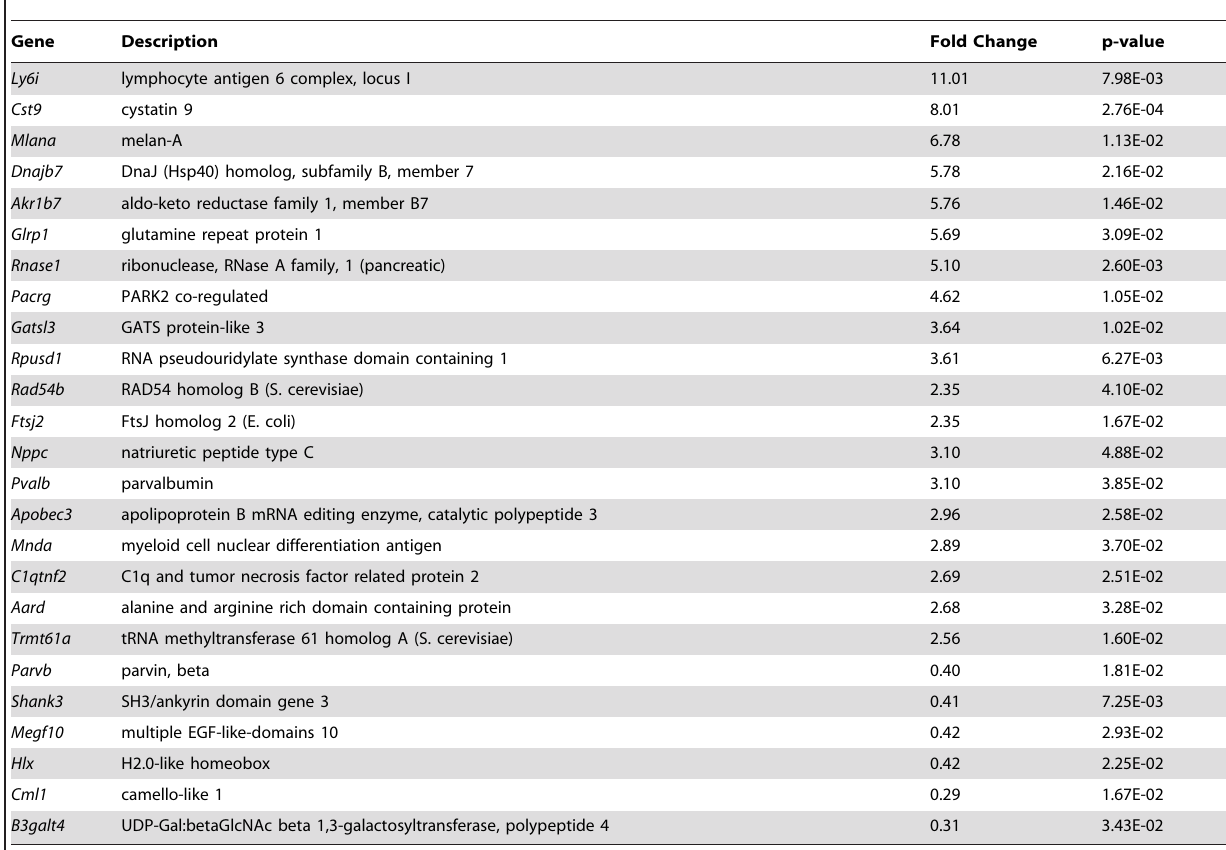
Table 1. Top 25 most differentially expressed protein-coding mRNAs ( . 1.5-fold change, p , 0.05) in Scx -/- atrioventricular canal samples compared to Scx + / +